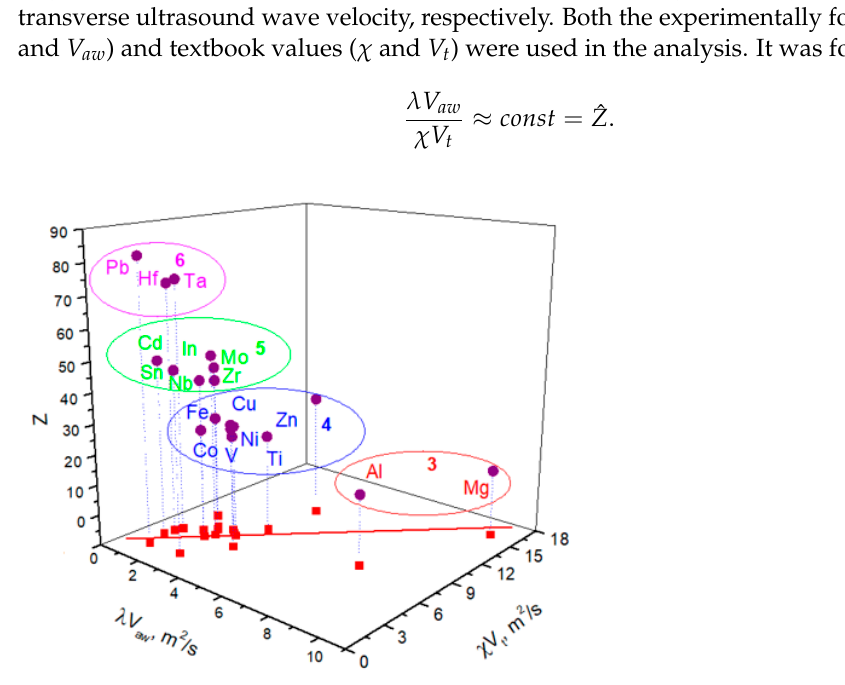
Figure 4. The elastic-plastic strain invariant (here Z is the atomic number of any element from the 3rd–6th periods of the periodic